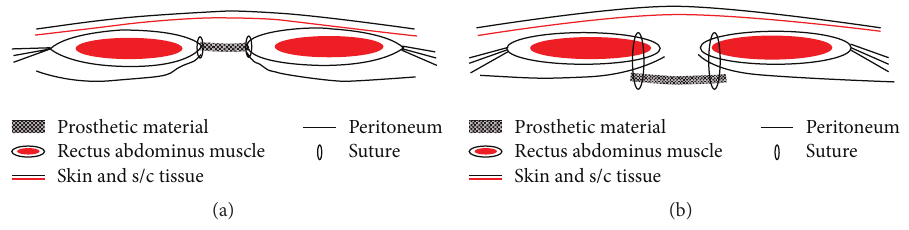
Figure 1: The techniques used for implantation of prosthetic materials [47]. (a) Inlay technique. (b) Underlay technique.